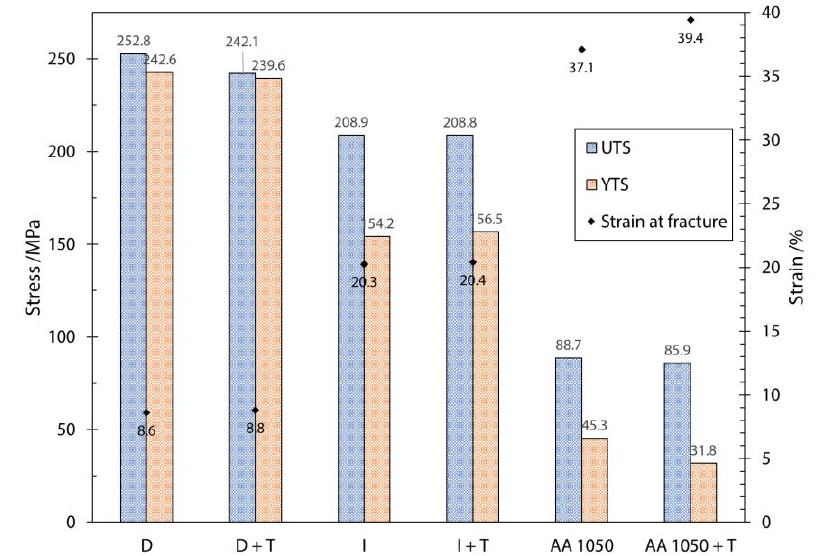
Figure 7. Summary of mechanical properties for extruded and for 20 h at 300 ◦ C annealed materials. Where D is direct press extruded, and D + T is direct press extruded and for 20 h at 300 ◦ C annealed sample; I is indirect press extruded sample; I + T is indirect press and for 20 h at 300 ◦ C annealed sample and similarly for direct-press-extruded AA 1050 Al, and the same also for 20 h at 300 ◦ C annealed AA 1050 sample.